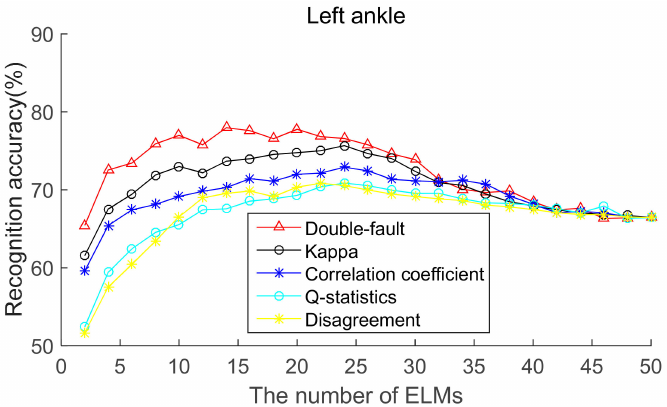
Figure 9. Recognition accuracy from left ankle position for ordered bagging according to five pairwise diversity measures.